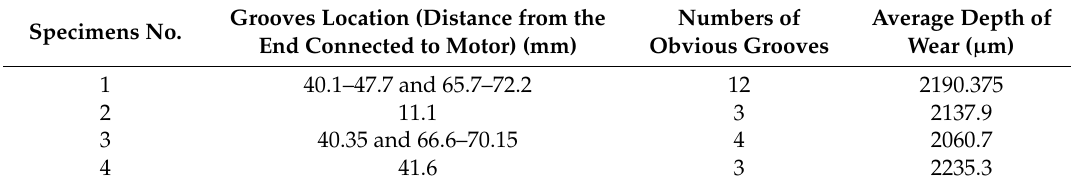
Figure 8. Micrographs of the first specimen: ( a ) 2D micrographs; ( b ) 3D micrographs.